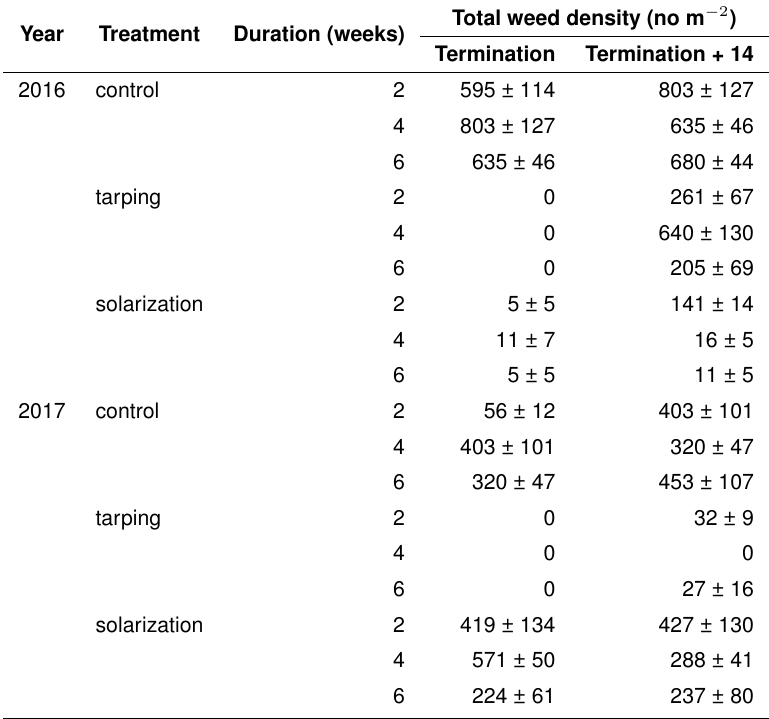
Table 5. Mean ± SEM total weed density measured during TARP